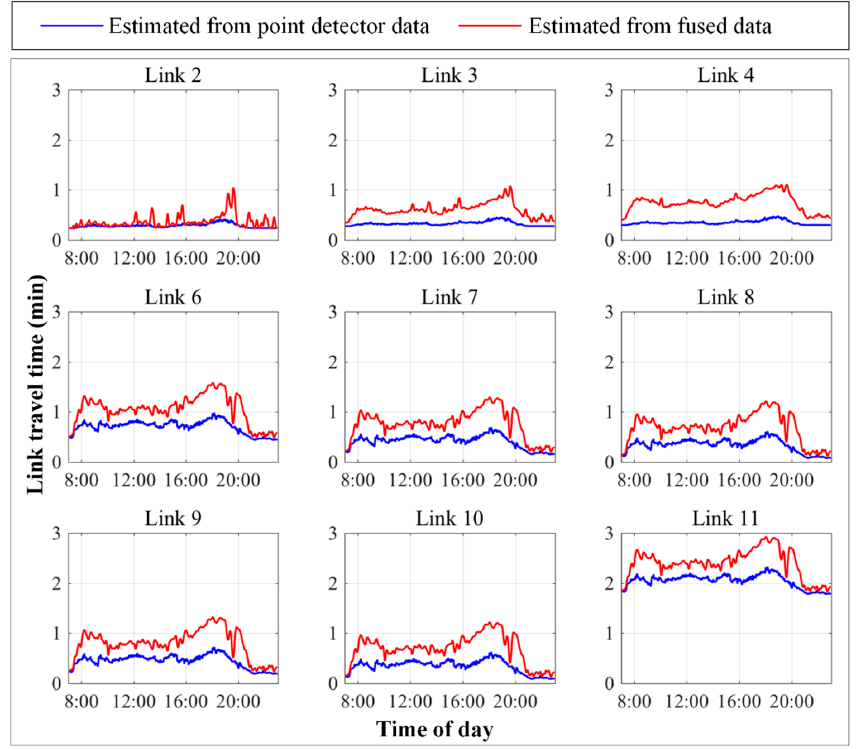
Figure 8. Individual link travel time distribution estimated from point detector data and fused data.